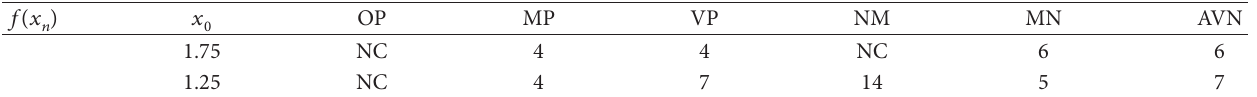
Table 3: The number of function evaluations required such that |1−𝑓(𝑥 𝑛 )/𝑓(𝑥 𝑒 )| < 10 −15 . NC states that the given method does not converge for the given root of (38) 𝑥 𝑒 = 0.5576473009191445 .